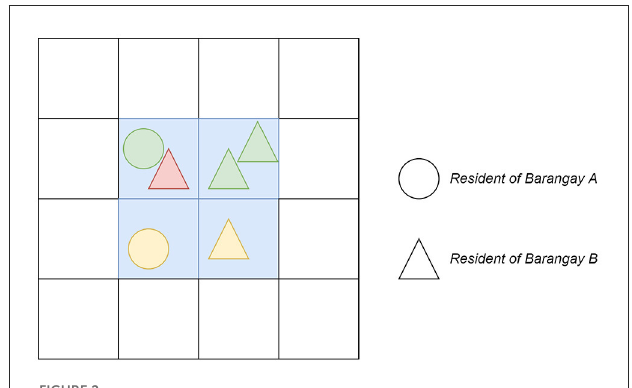
FIGURE2 Visual representation of the two-dimensional world grid with several resident interactions. The circle-shaped resident belongs to barangay B, while the triangle-shaped resident belongs to barangay A. The red color represents an infected resident , the yellow color represents an exposed resident , and the green color represents a susceptible resident . The infected resident has the probability to transmit the virus to a susceptible resident within the same grid. Susceptibles or exposed residents in the neighboring grids cannot possibly be exposed by the same infected resident